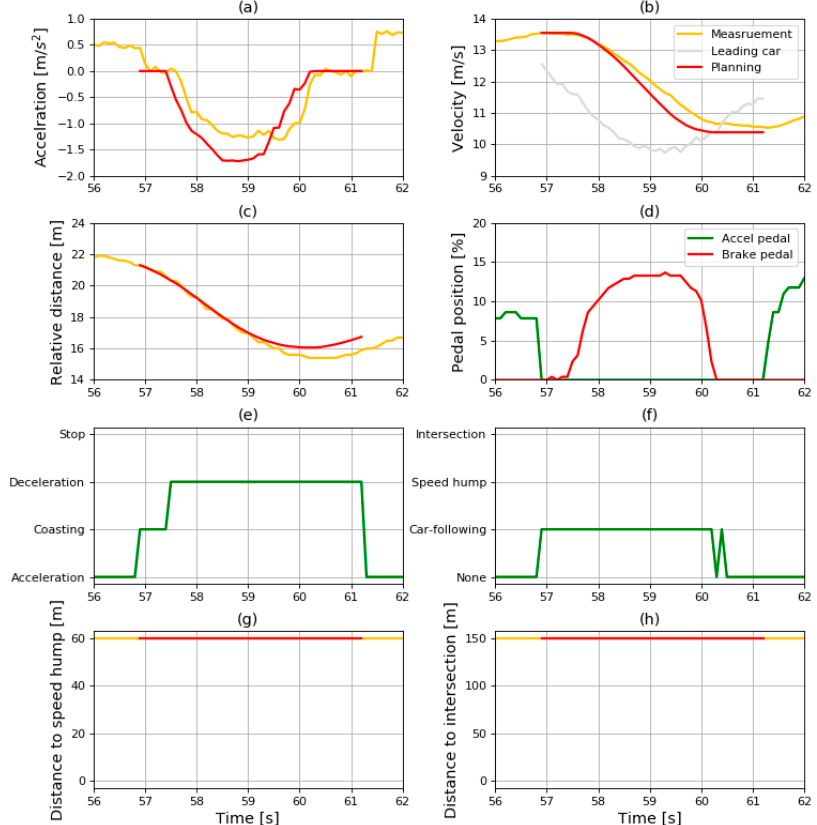
Figure 16. Sliced results of ( a ) acceleration; ( b ) velocity; ( c ) relative distance; ( d ) pedal position; ( e ) driving state; ( f ) deceleration condition; ( g ) distance to speed hump; ( h ) and distance to intersection in car-following condition.